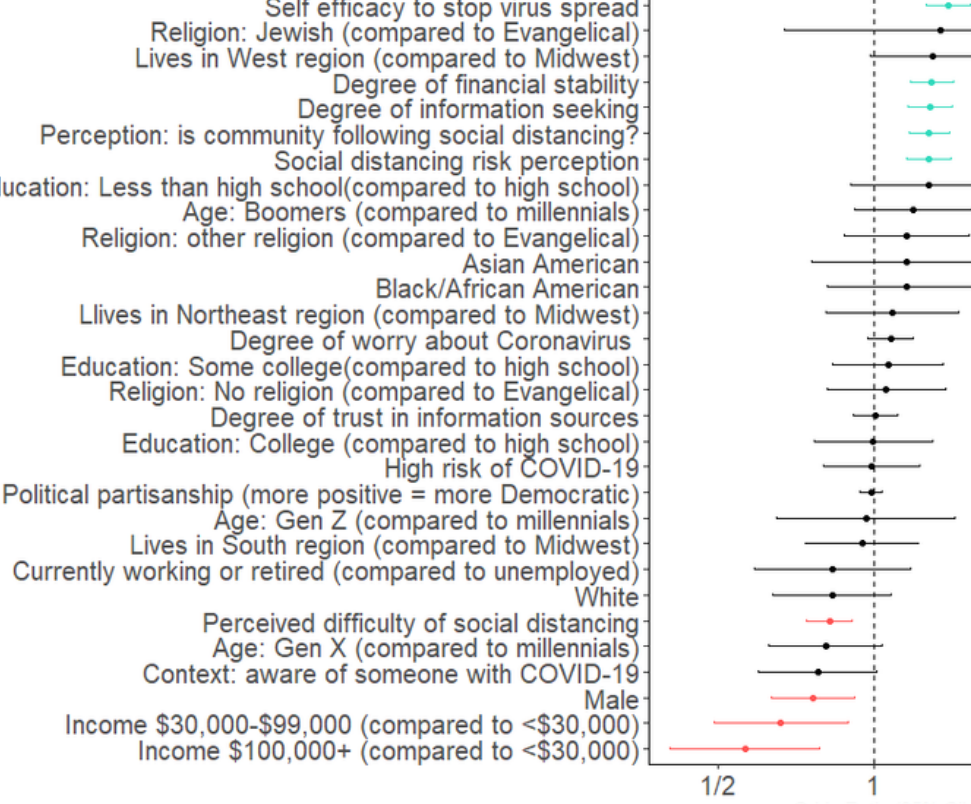
receiving in-person services—were less likely to social distance (OR = 0.85; 95% CI = 0.79–0.92; p < .001).